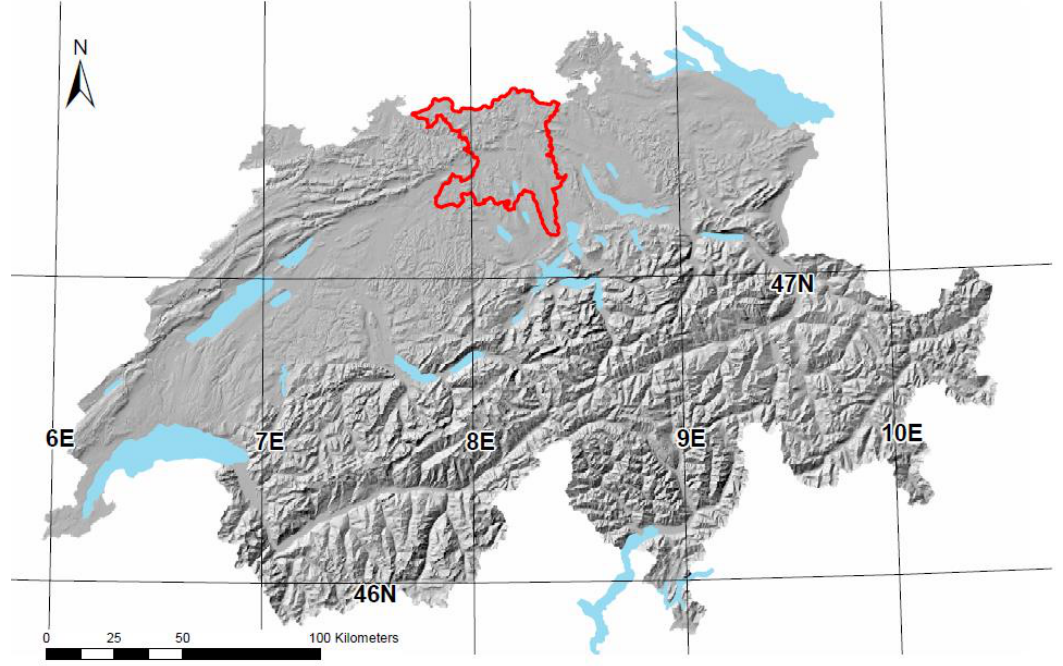
Figure 1. Location and size of canton Aargau, Switzerland.